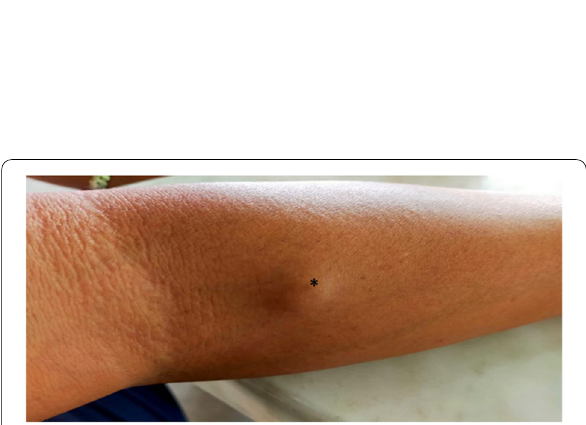
Fig. 2 View of papulonodular lesion at forearm (*)